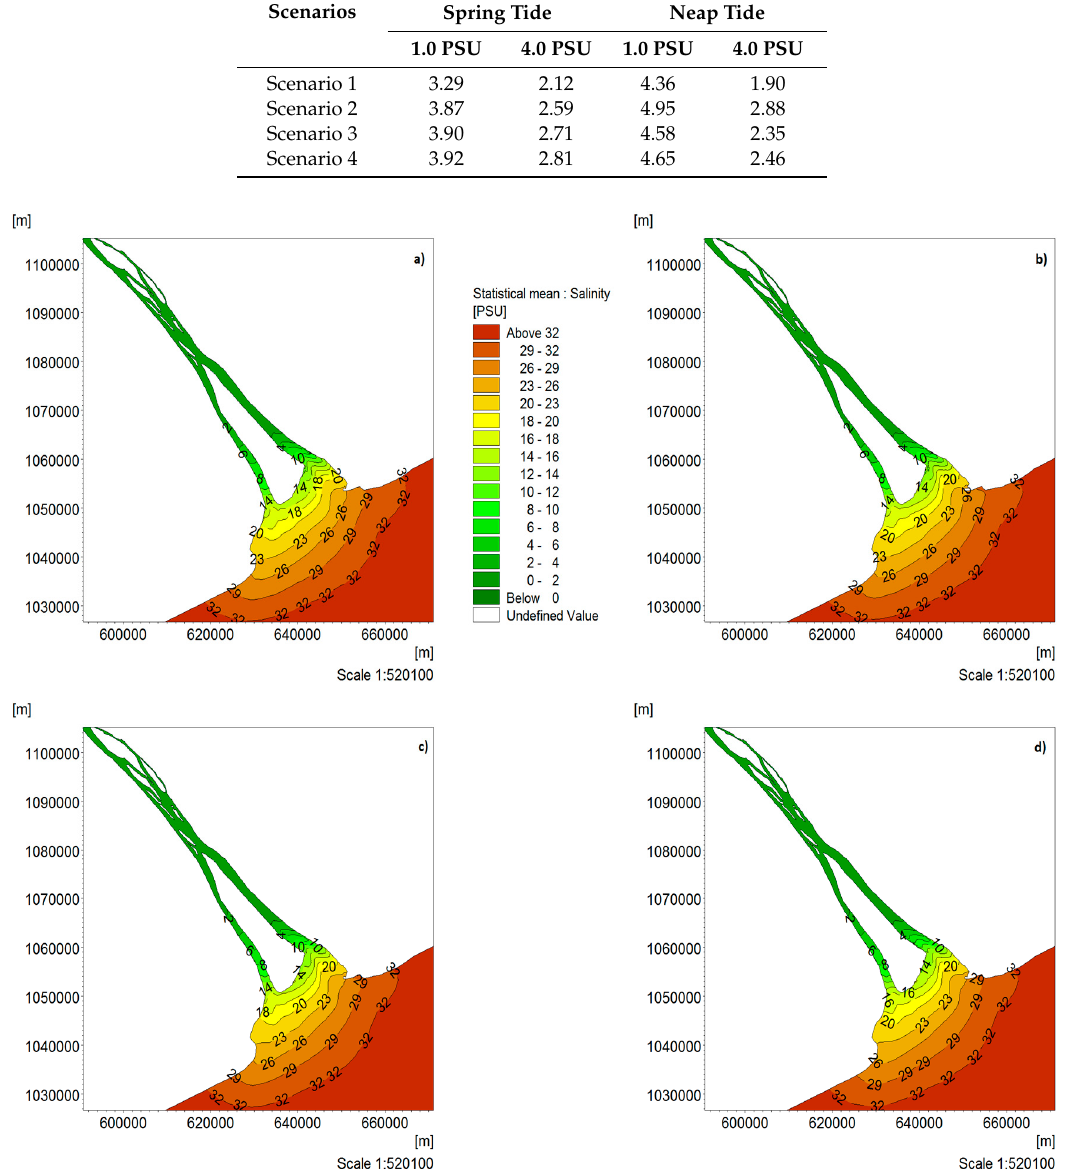
Figure 10. Spatial distribution of average salinity concentration across the modelling domain under Scenario 1 ( a ), Scenario 2 ( b ), Scenario 3 ( c ) and Scenario 4 ( d ).